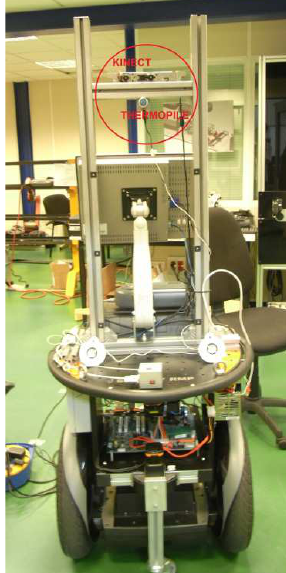
Figure 1. The robotic platform used: a Segway RMP200 provided with the Kinect and the thermal